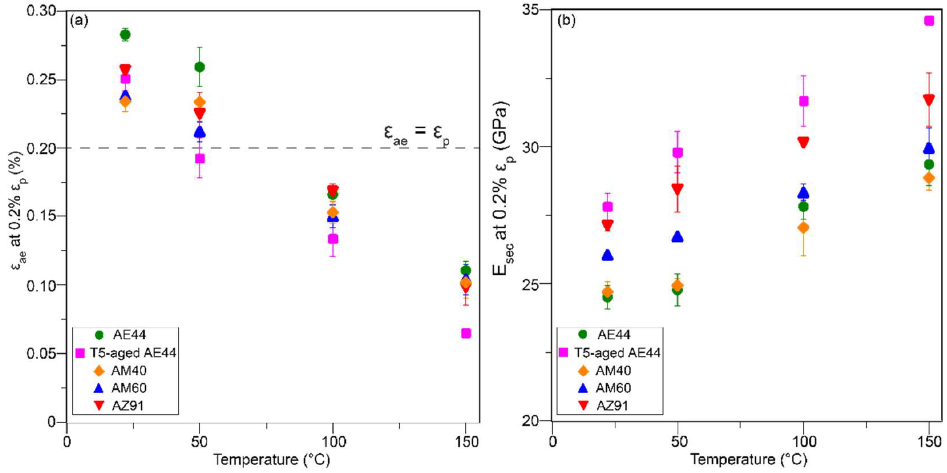
Figure 6. The magnitude of ( a ) anelastic strain, ε ae , and ( b ) secant elastic modulus, E sec , at 0.2% plastic strain, ε p . The values shown are averaged from two to three repeated tests. Dashed line shown in ( a ) indicates ε ae = ε p .